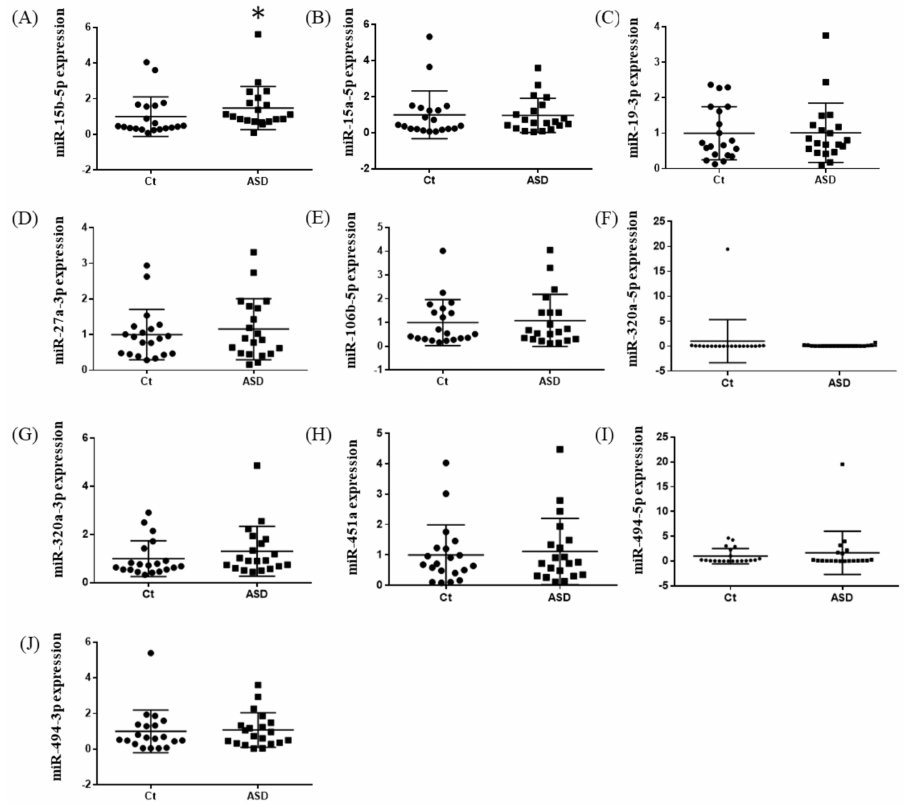
Figure 5. Expression of ten miRNAs in the replication cohort. The y -axis represents the ratio of relative expression values of the control and ASD subjects. The expression of the ten miRNAs were measured by qPCR: ( A ) miR-15b-5p, ( B ) miR-15a-5p, ( C ) miR-19b-3p, ( D ) miR-27a-3p, ( E ) miR- 160b-5p, ( F ) miR-320a-5p, ( G ) miR-320a-3p, ( H ) miR-451a, ( I ) miR-494-5p, and ( J ) miR-494-3p. miR, microRNA; Ct, controls; ASD, autism spectrum disorder. * p < 0.05.